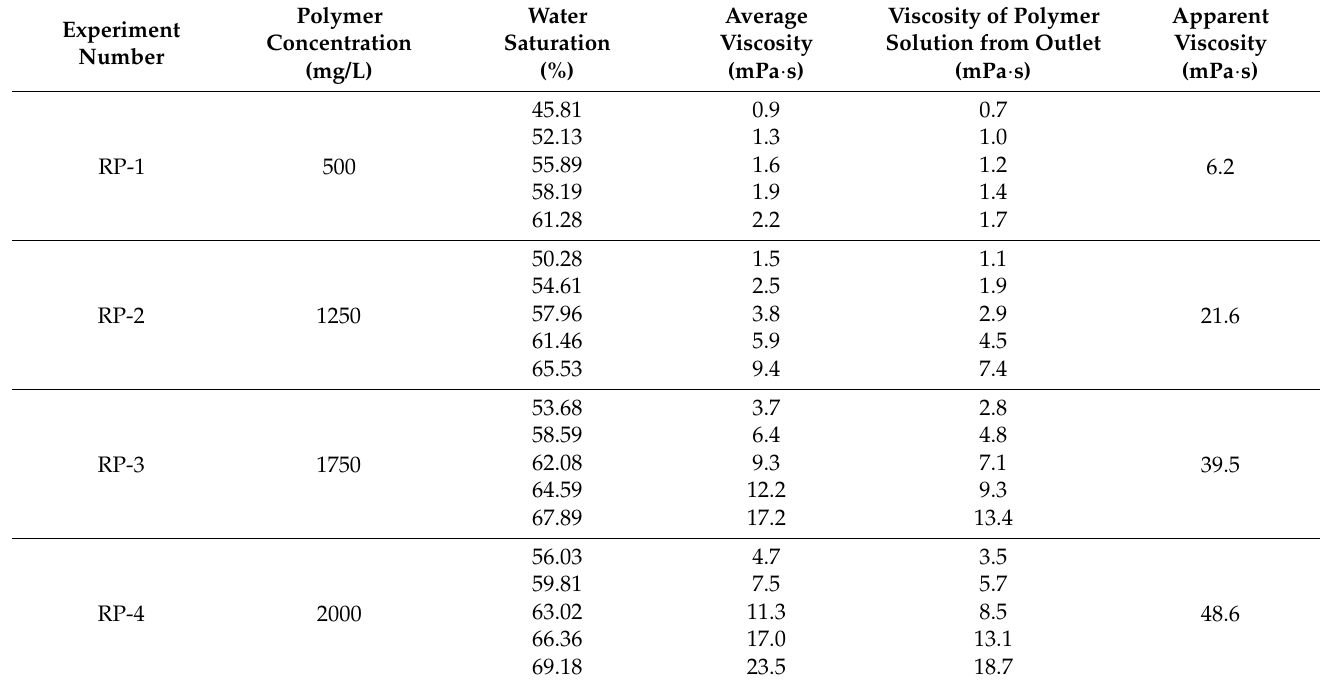
Table 4. Average viscosity calculated by integral formula and other viscosities.